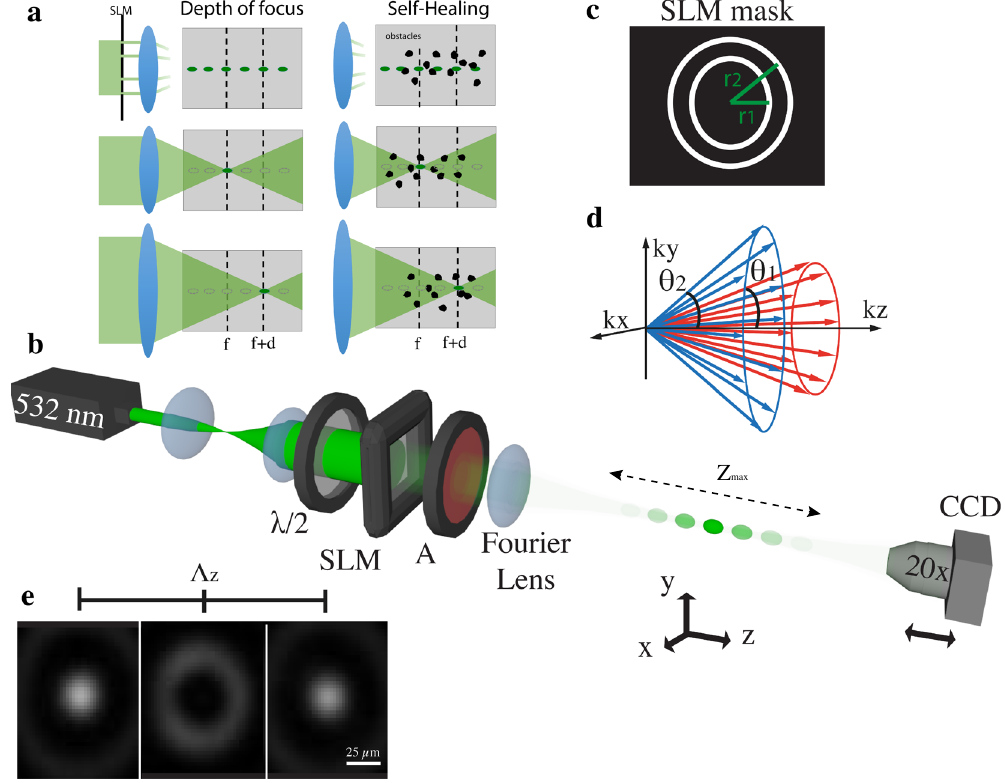
Figure 1. Schematic of a light droplet illumination in contrast with a standard Gaussian configuration ( a ). A Gaussian beam can illuminate a single voxel at different depths in a sample volume through lenses of different focal lengths. In turn, light droplets are periodic structures which enable a localised illumination along the whole optical axis. Optical setup diagram ( b ). A binary mask ( c ) displaying two concentric annuli of different diameters is generated on the SLM. This operates in amplitude mode through a λ /2 plate and a crossed analyser (A). The resulting field distribution gives rise to two co-propagating Bessel beams of different k -vectors ( d ). The beams are recorded through a 20x objective lens and a CCD camera. Transverse intensity distributions at three different positions along a period of Λ z = 4 mm ( e